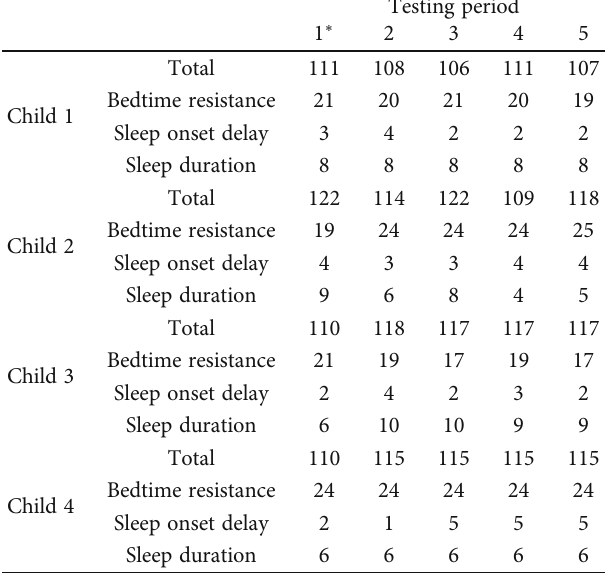
∗ Note. 1: before baseline; 2: after baseline. before introducing intervention; 3: after 1 st intervention phase; 4: after 2 nd baseline phase; 5: after 2 nd intervention phase. Table 3: Children ’ s Sleep Habit Questionnaire total scores and subscale scores for each